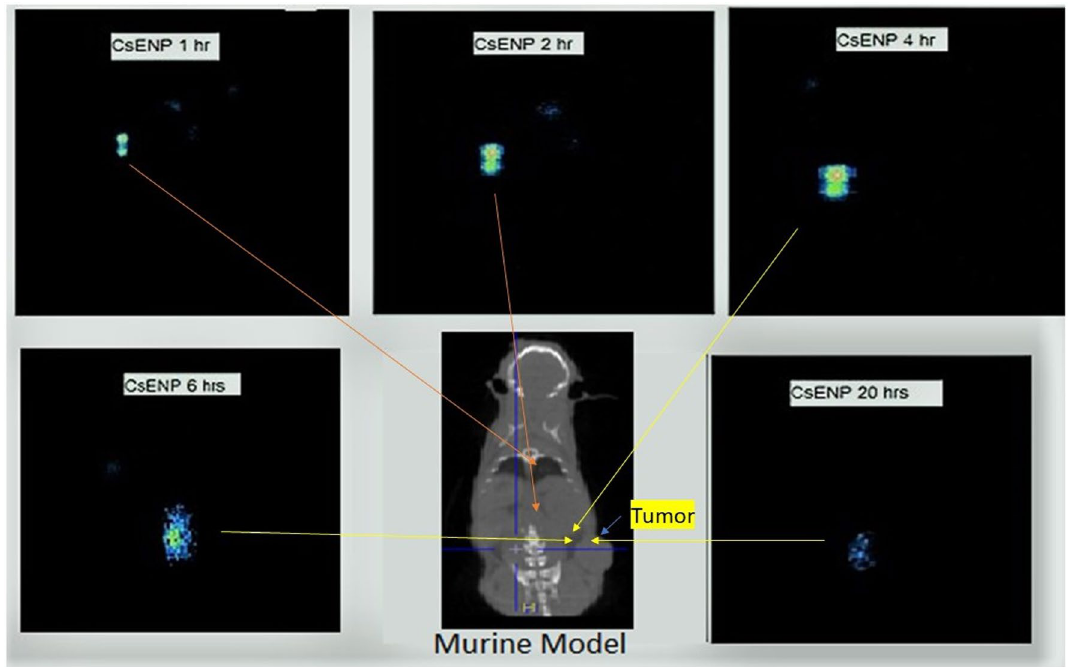
Fig. 2 Gamma Scintigraphic images of CsENP in mice at different time intervals